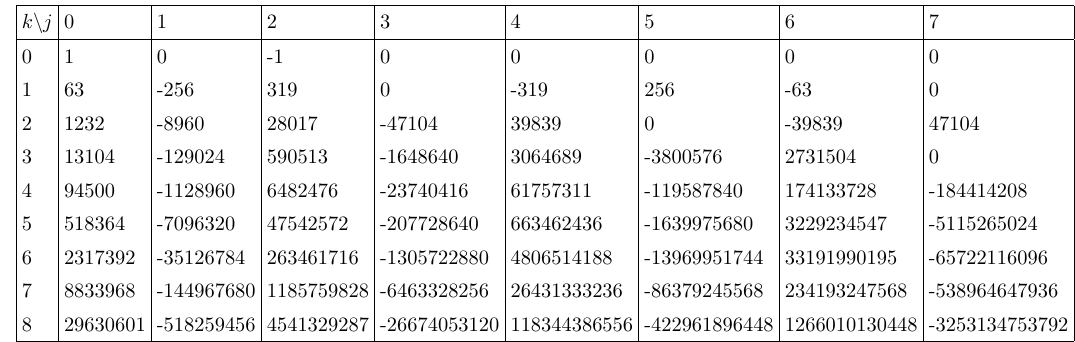
Table 53. Table of b jk coe(cid:14)cients for h SU(8)